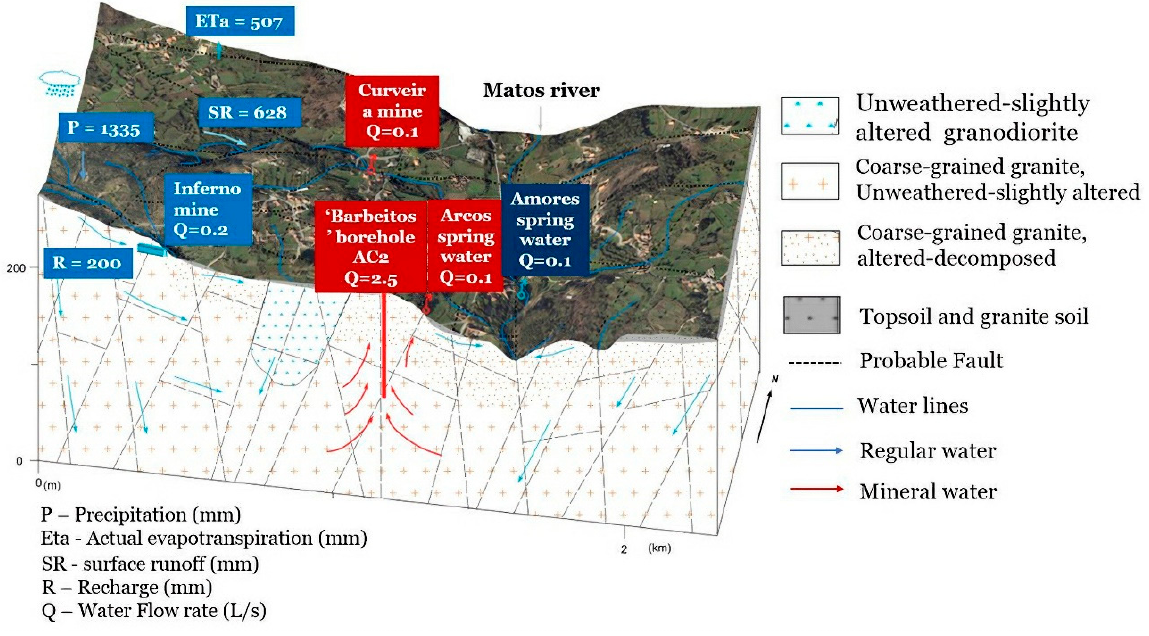
Figure 6. Conceptual hydrogeological model of the area surrounding the ‘Barbeitos’ borehole (adapted from [68]).